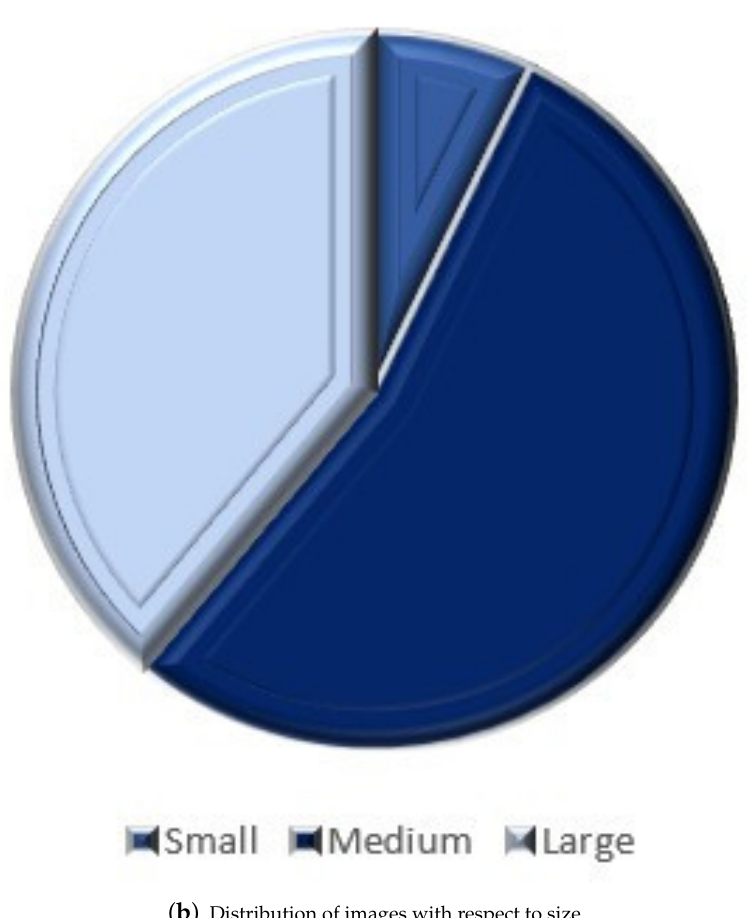
Figure 11. The vehicle distribution and count of vehicles per